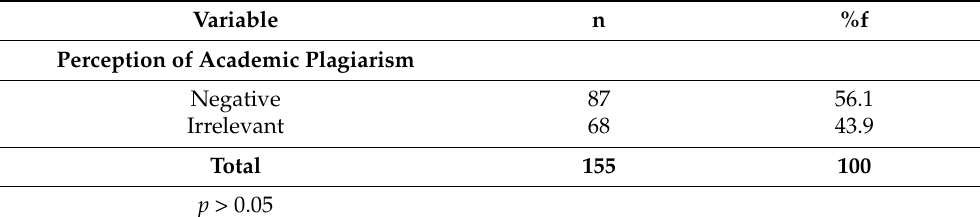
Table 2. Level of perception of academic plagiarism in students at the school of industrial engineering of a public university in